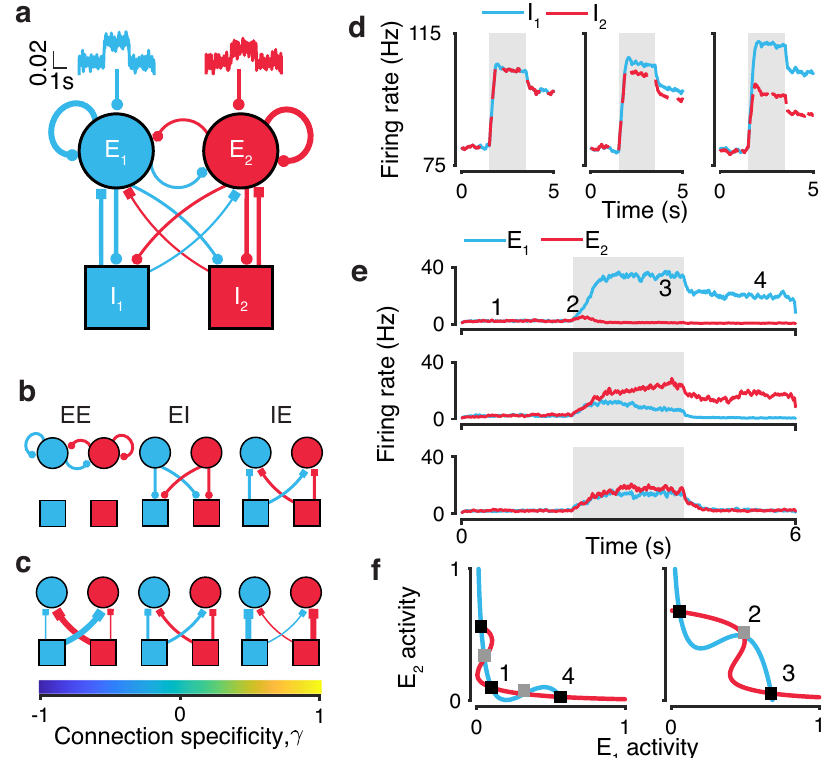
Fig. 1 | A mean- fi eld circuit model of decision making with choice-selective elevating the fi ring rate of one excitatory population. Example trials showing E 1 inhibition.a Thecircuitdiagramofthemodelwithchoice-selectiveexcitatoryand (blue) and E 2 (red) population activity for stimulus strength equal to 20 (upper panel), and for stimulus strength equal to 0 on a completed (middle panel) and inhibitory populations. b The circuit model includes three connection classes: invalid trial (lower panel). Gray shading indicates stimulation period. Numbers excitatory-excitatory (EE), excitatory-inhibitory (EI), and inhibitory-excitatory (IE). c Theparameter γ controls the speci fi city of connections between choice-selective indicateactivitycorrespondingto fi xedpointsin f . f Eight fi xedpointsarerequired for decision-making dynamics in the circuit: fi ve in the unstimulated phase-plane populations. The output connections preferentially target neurons with the same (left)andthreeinthestimulatedphase-plane(right,stimulusstrengthisequalto0). choicepreferencewhen γ ispositive,andwiththeoppositechoicepreferencewhen γ is negative. d γ Lines show nullclines of E 1 and E 2 populations, black squares indicate fi xed-point EI controls inhibitory choice selectivity. Firing rate of inhibitory populations for γ EI =0 (left), γ EI =0.05 (center), γ EI =0.25 (right) are shown for an attractors, and gray squares indicate saddle-points for a circuit with nonselective example trial with stimulus strength equal to 20. e Circuits report choices by